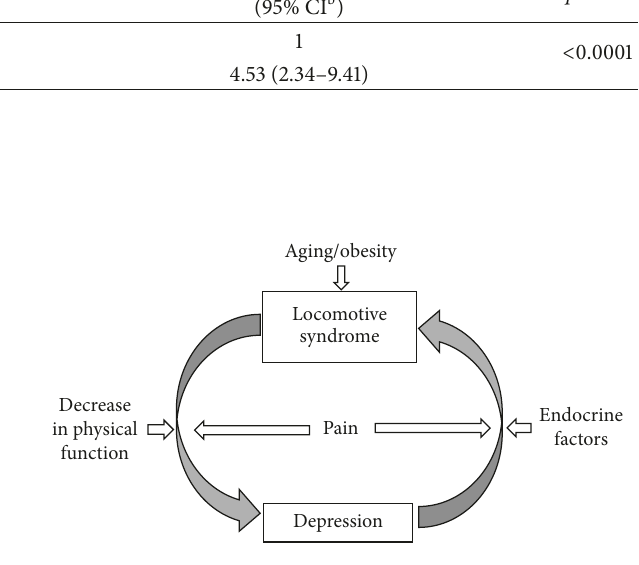
Figure 1: Association between locomotive syndrome and depres-